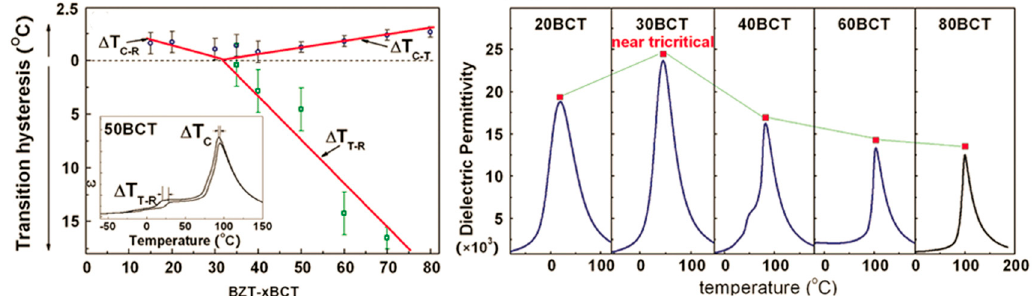
Figure 12. Thermal hysteresis studies ( left ) and permittivity maximum measurement ( right ) indicates a tricritical point for the triple point of BZT–BCT [14].